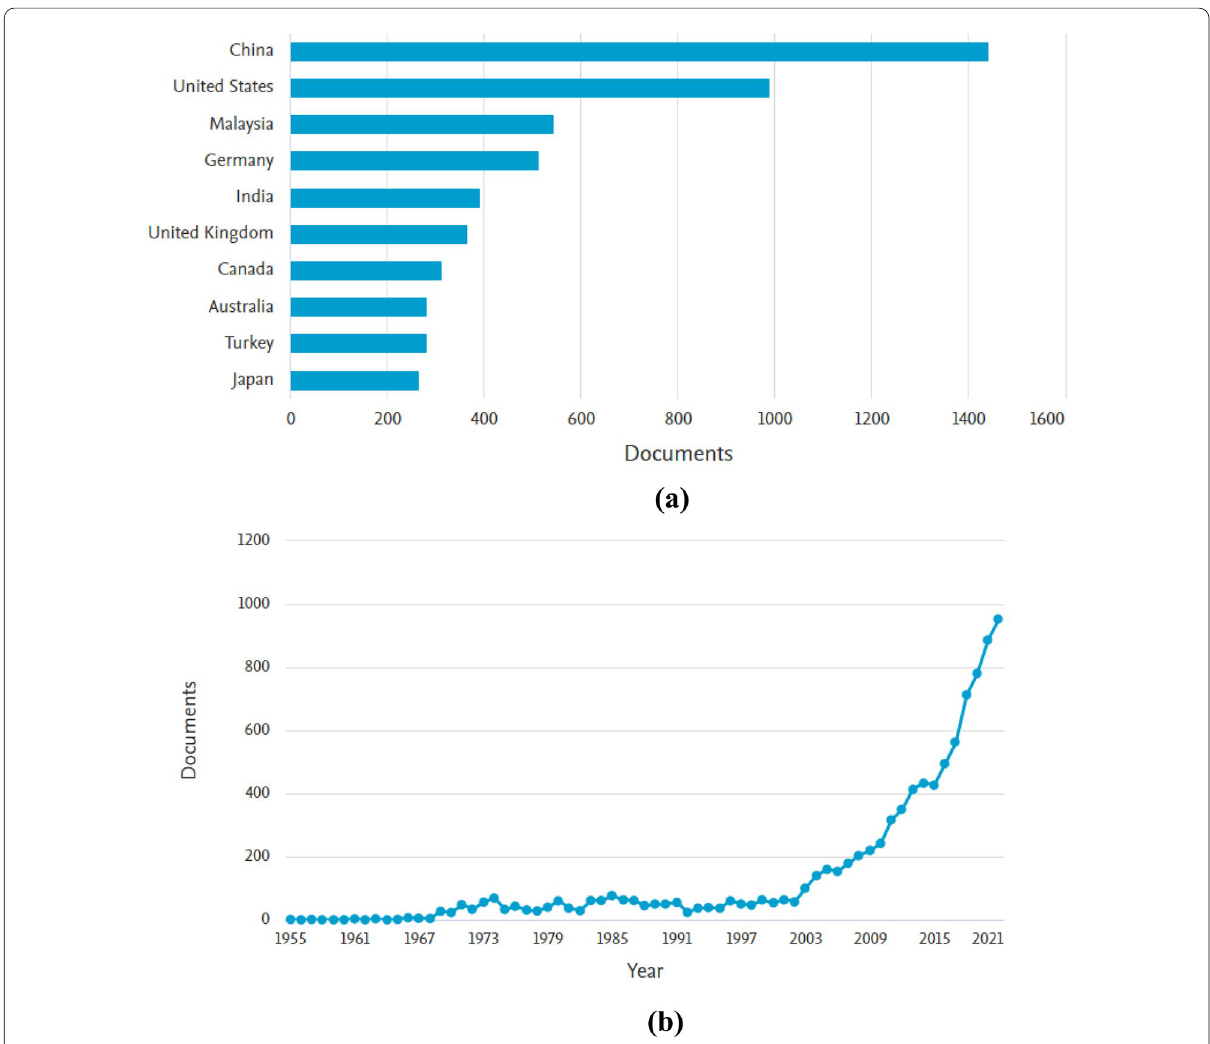
Fig. 1 a Country-wise observed research pattern. b Year-wise observed research